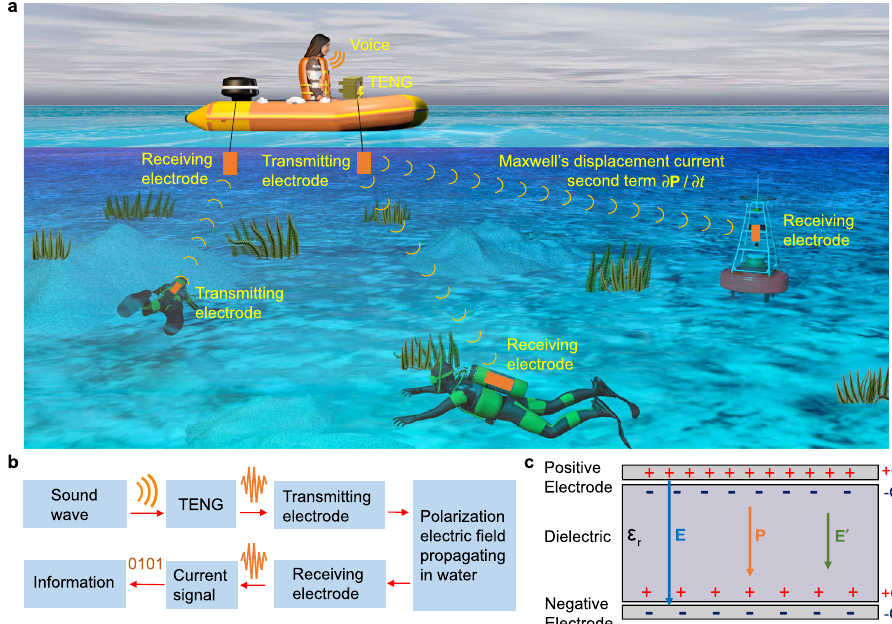
Fig. 1 Conceptual diagram of the underwater wireless communication. (signals generated by TENG is directly transmitted without ampli fi cation by an external power source). a The application and ( b ) the fl ow chart of the underwater wireless communication. c Schematic diagram of the capacitance model, ε r is relative permittivity, E is the original electric fi eld, P is the polarization electric fi eld, E ′ is the combined electric fi eld of ( E ) and ( P ), and all about Q are amount of